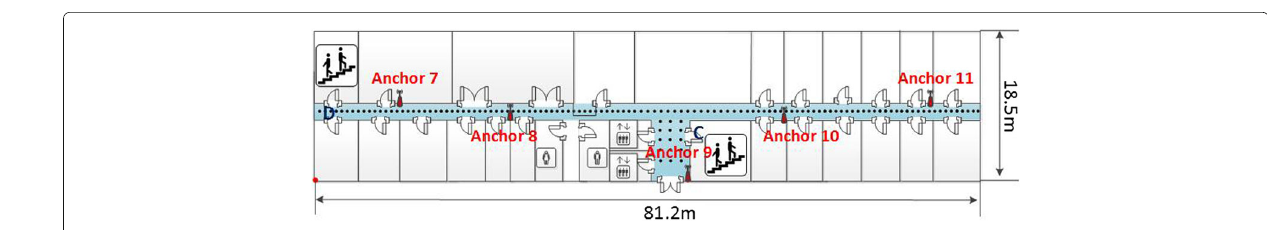
Fig. 18 Floor plan of the upper floor